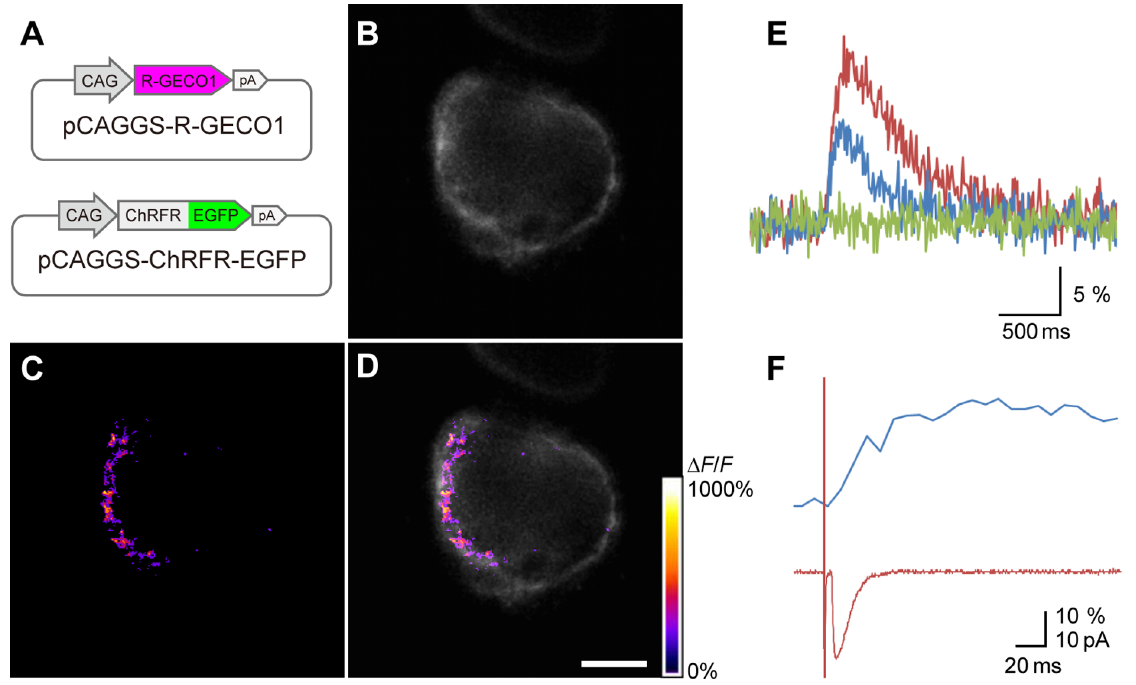
Figure 3. Ca 2 + imaging of the calyx-type presynaptic terminal. A , Schematic structures of injected plasmid vectors, pCAGGS-ChRFR-EGFP (top) and pCAGGS-R-GECO1 (bottom). B , A confocal EGFP image of a calyx-type presynaptic terminal (E14) (optical slicing at 1.99 m m). C , A color- rated image of the D F / F of R-GECO1 immediately after electrical stimulation of the oculomotor nerve in the same optical slice. D , Overlay of B and C. Note that several hotspots are present in the synaptic face of the calyx. Scale bar, 10 m m. E , Time-dependent plots of bulky magnitudes of D F/F ([ D F/ F ] B ). The concentration of the extracellular Ca 2 + was 5 mM (red), 2.5 mM (blue) and 0 mM (green). The oculomotor nerve was electrically stimulated as indicated (arrow). F , Simultaneous recordings of the [ D F/F ] B (blue) and the EPSC